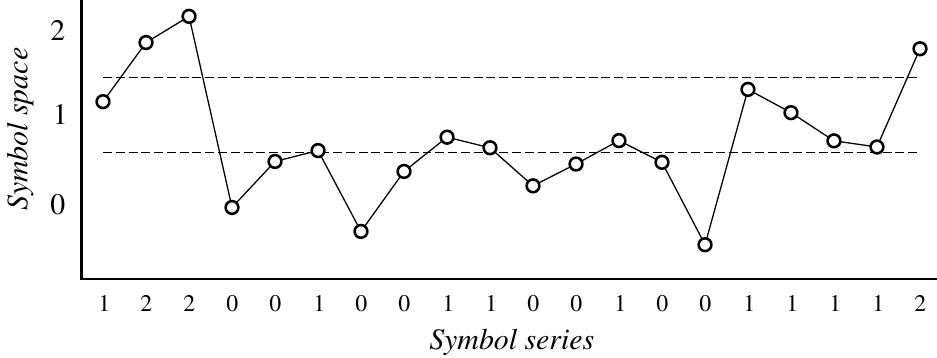
Figure 6. Procedure for conversion of a time series to symbol series for a n = 3